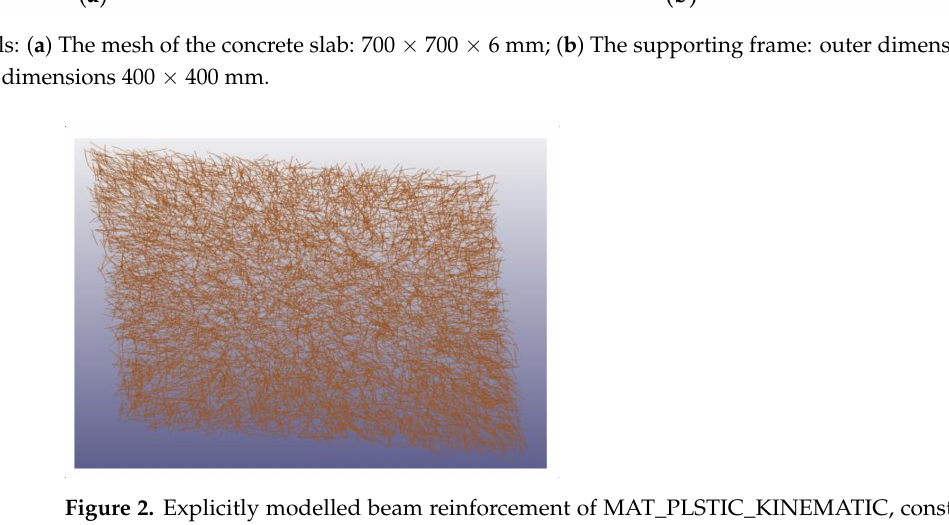
Figure 2. Explicitly modelled beam reinforcement of MAT_PLSTIC_KINEMATIC, constrained in 700 × 700 × 60 mm concrete